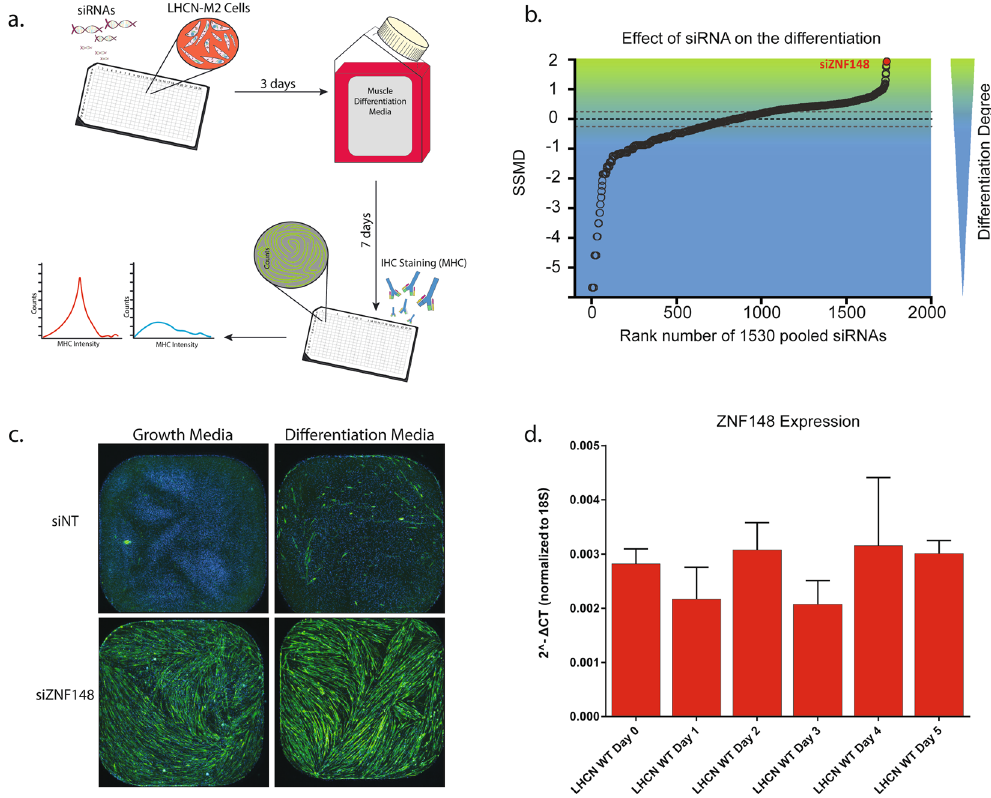
Figure 1. Transcription factor siRNA library screening of LHCN-M2 cells for positive and negative regulators of muscle differentiation. ( a ) Screening design schematic. ( b ) Rank of the strictly standardized mean difference (SSMD) values in the siRNA screen. SSMD values permit statistical scoring of the degree of cell differentiation by considering the area of positive myosin heavy chain (MHC) staining. ( c ) Representative images of cells treated in growth or differentiation culture conditions with nontargeting siRNA (siNT) and the top hit siRNA ZNF148 (siZNF148). ( d ) ZNF148 expression determined by qPCR of LHCN-M2 cells cultivated in either growth (Day 0) or differentiation media (Day 1–5). “WT” represents untreated